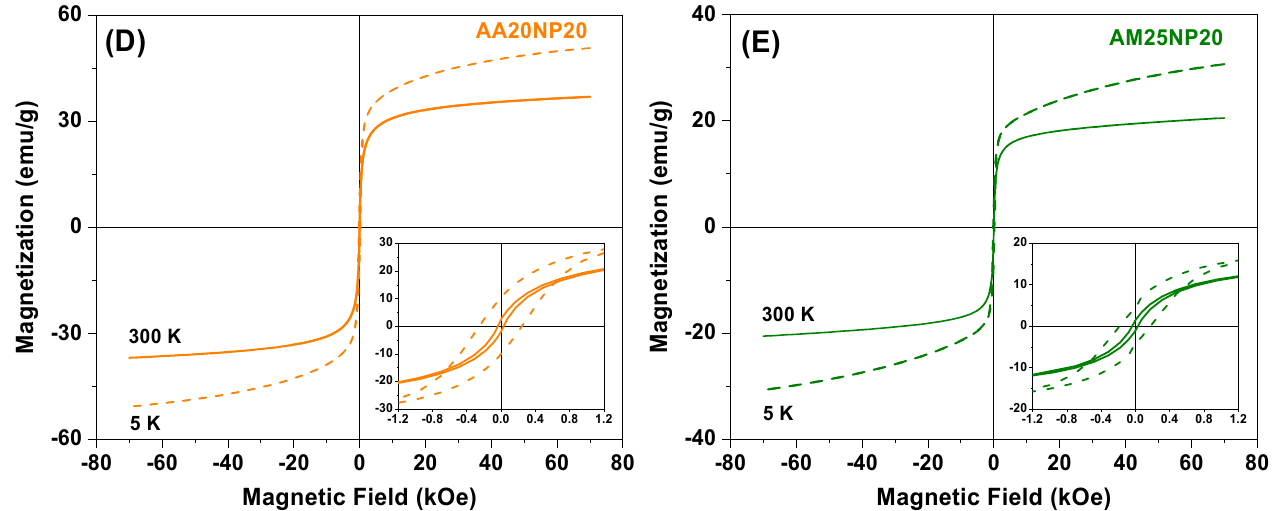
Figure 5. Magnetization curve of ( A ) non-modified Fe 3 O 4 ; ( B ) surface-modified Fe 3 O 4 with acrylic acid; ( C ) surface-modified Fe 3 O 4 with methacrylic acid; ( D ) magnetic poly(vinyl pivalate) containing Fe 3 O 4 modified with acrylic acid (AA20NP20); ( E ) magnetic poly(vinyl pivalate) containing Fe 3 O 4 modified with methacrylic acid (AM25NP20). The dashed line refers to the temperature of 5 K and the continuous line to 300 K.